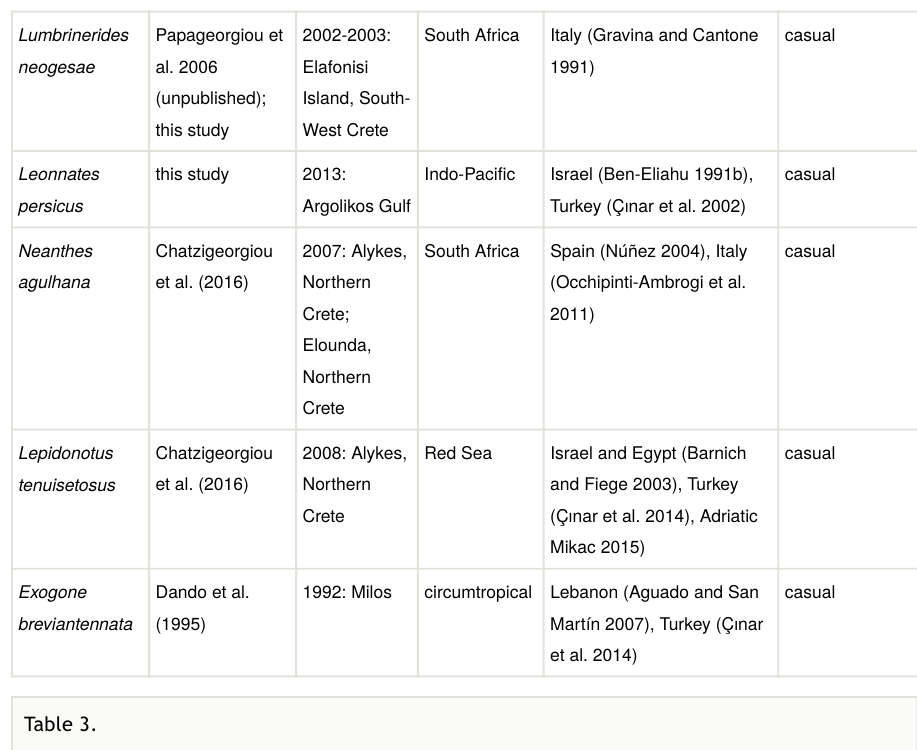
Taxa reported at genus level with no species-level representatives known from